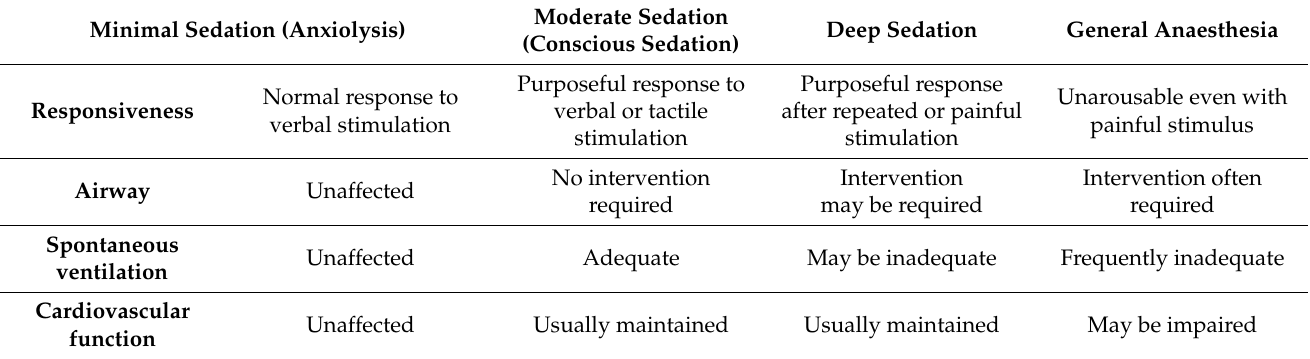
Table 1. Levels of sedation and